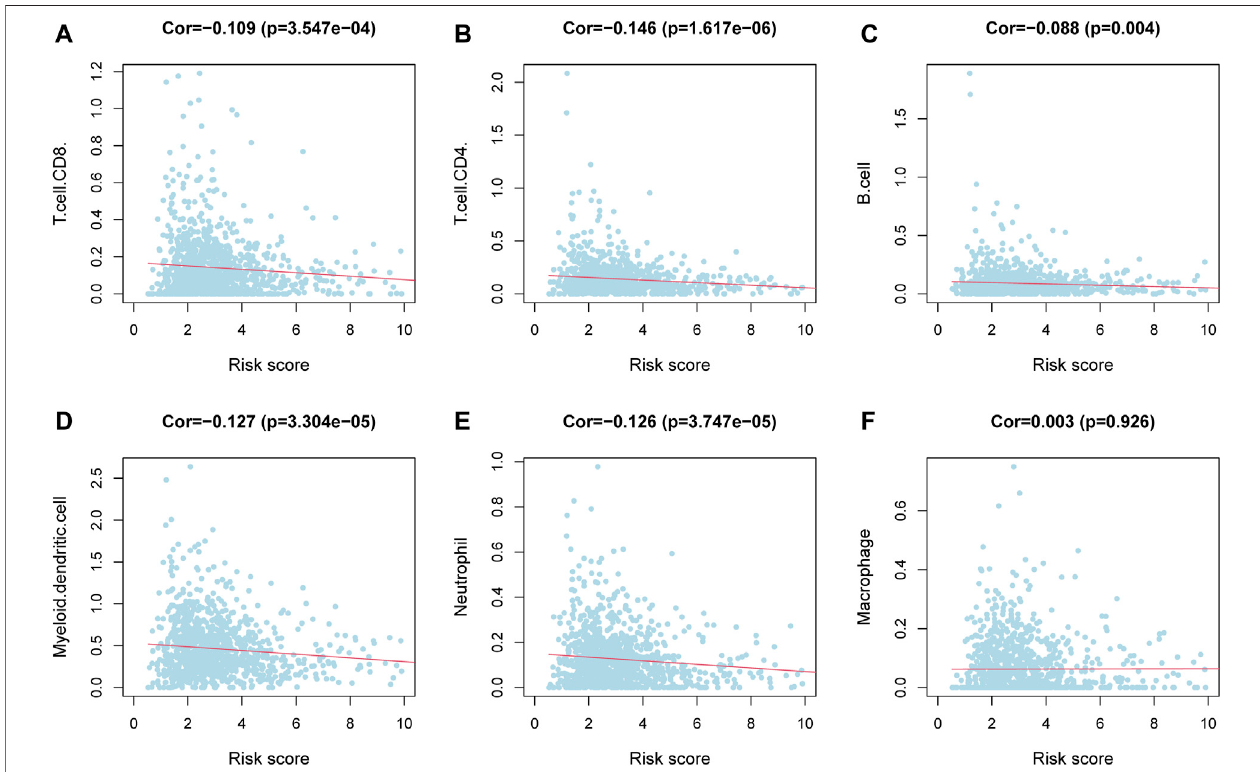
FIGURE 8 | Correlation between immune cells and m6aRiskscore was analyzed using the TIMER database. (A – F) Correlation analysis between immune cells and m6aRiskscore in TCGA-BRCA cohort.